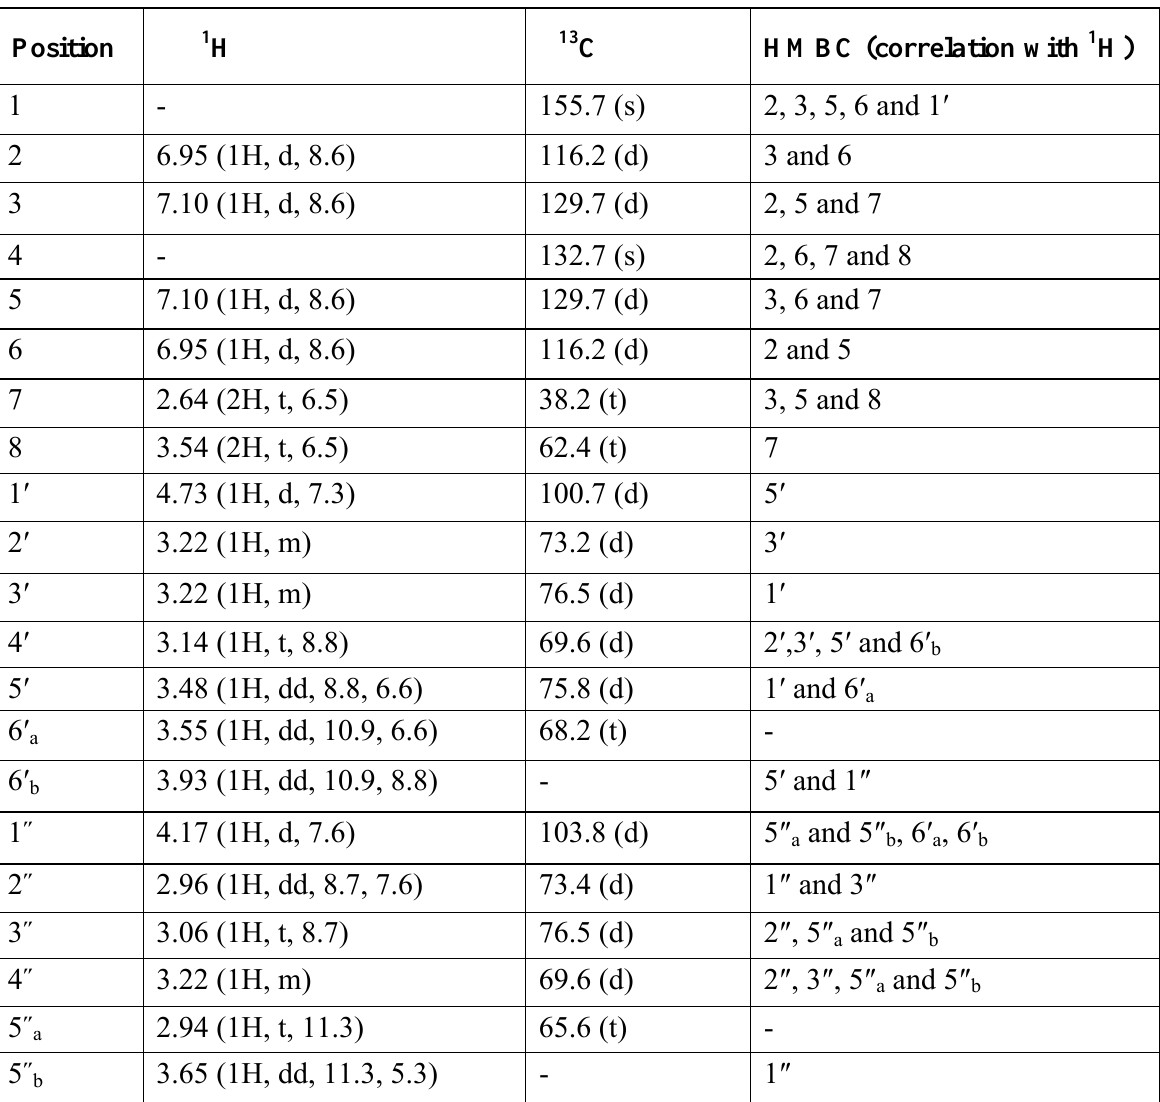
Table 2. 1 H- (500 MHz) and 13 C-NMR (125 MHz) data of 10 (DMSO- d J in Hz) and HMBC